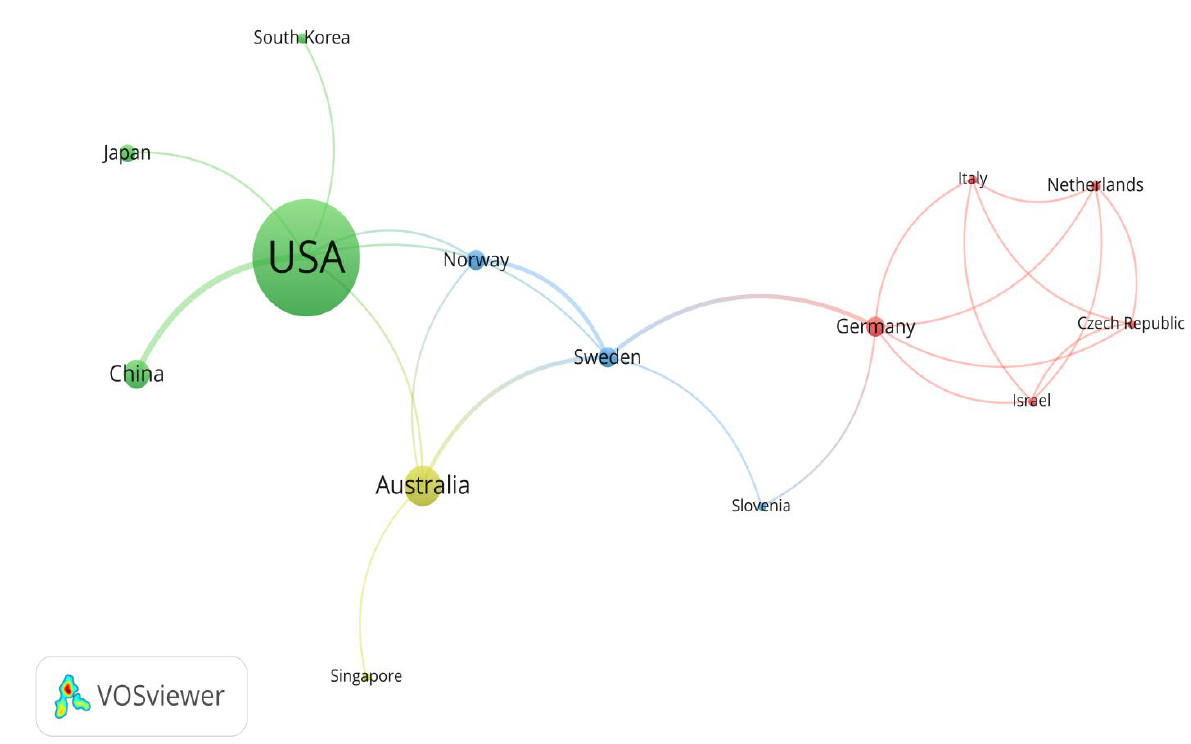
Figure 6. Map of countries actively engaged in research on the rural institutional elder care. Table 3. Table of countries actively engaged in research on rural institutional elder Figure 7 is drawn according to the geographical location, the number of published articles, and the average normalized citation of 14 countries that are actively engaged in rural institutional elder care research. Researchers for developed countries such as the USA, Australia, Germany, and Norway devote significant efforts to researching rural institutional elder care. However, an emerging trend has also been found in other developing countries like China, with increasing enthusiasm in investigating rural institutional elder care, probably due to their ever-growing elderly population.